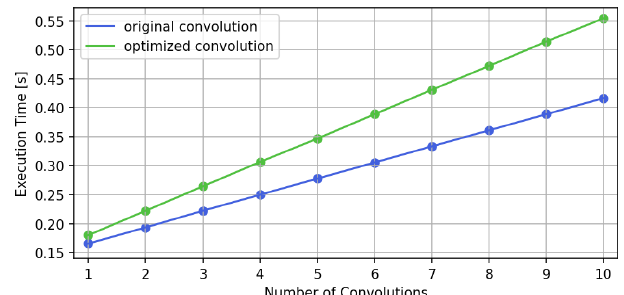
Figure 7. Plot of execution times from Table 4 against number of performed convolutions for both the original and the optimized con- volution algorithms.